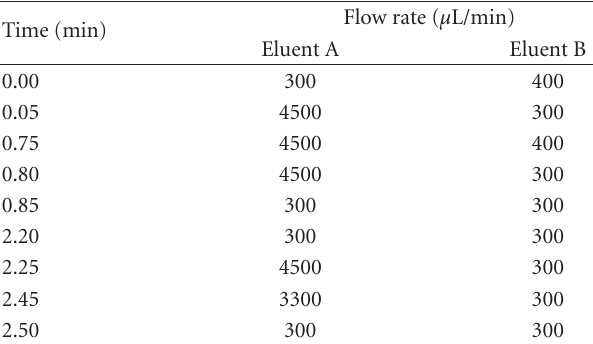
Table 1: Timetable for pump